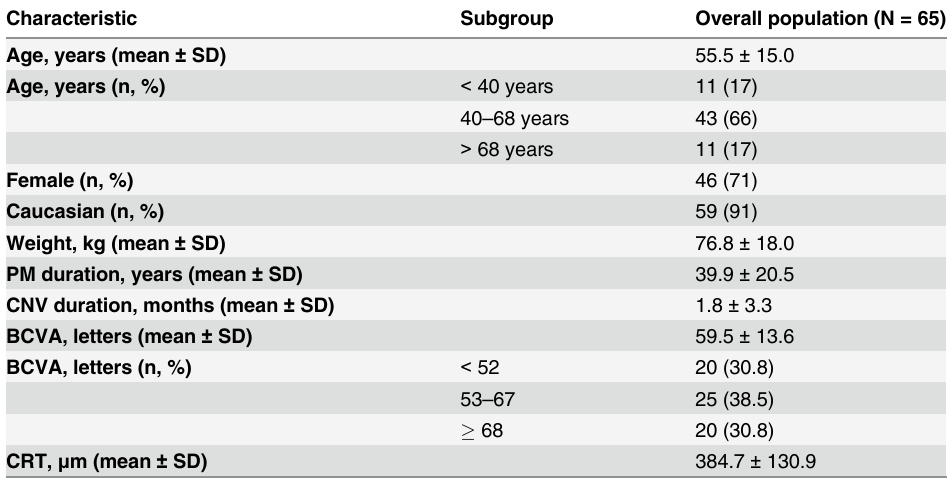
Table 1. Patient demographics and baseline characteristics.